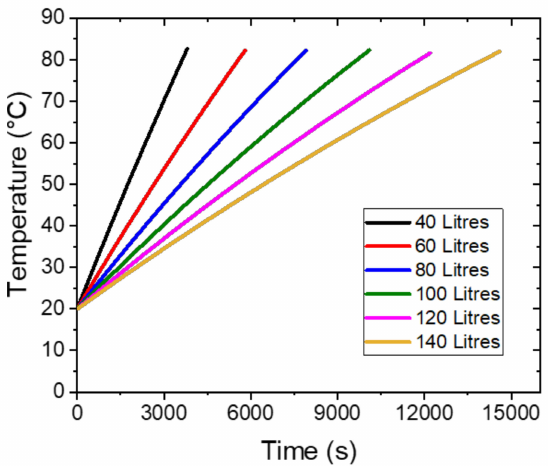
Figure 3. Temporal variations of water temperature for different tank capacities.